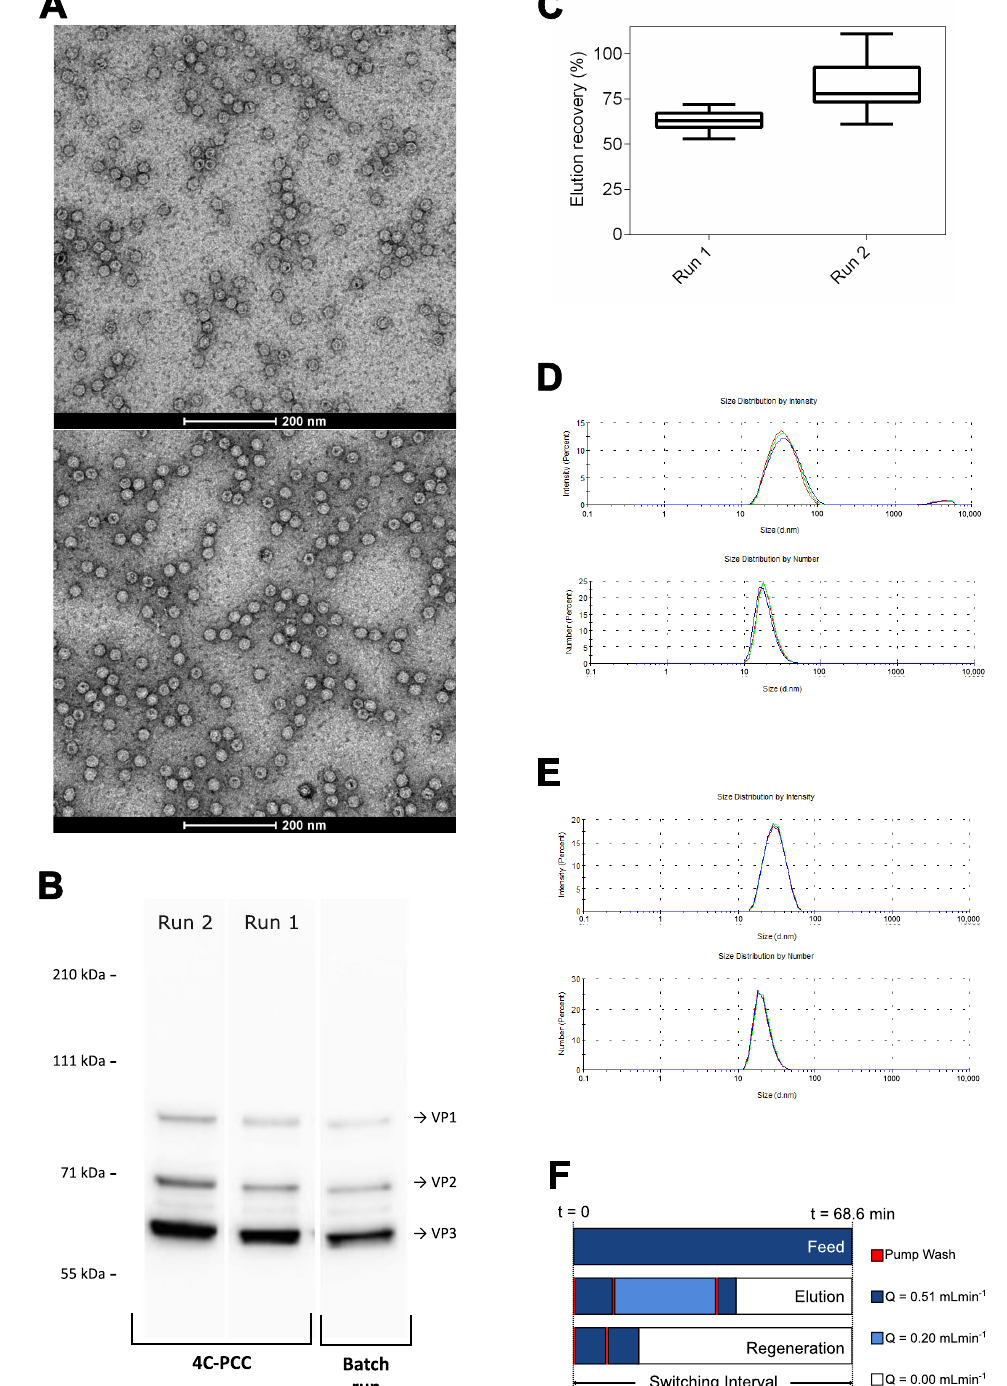
Figure 6. Characterization of the eluted pools from PCC runs 1 and 2: ( A ) transmission electron microscopy (top, PCC run 1; bottom, PCC run 2); ( B ) Western blot targeting AAV capsid proteins; ( C ) elution recovery, calculated using ELISA. Dynamic light scattering analysis (n = 3) of ( D ) PCC run 1 and ( E ) PCC run 2; for both runs, the top distributions are intensity-weighted and the bottom distribution are number-weighted. ( F ) Occupation of sample, system A and system B pumps in the PCC